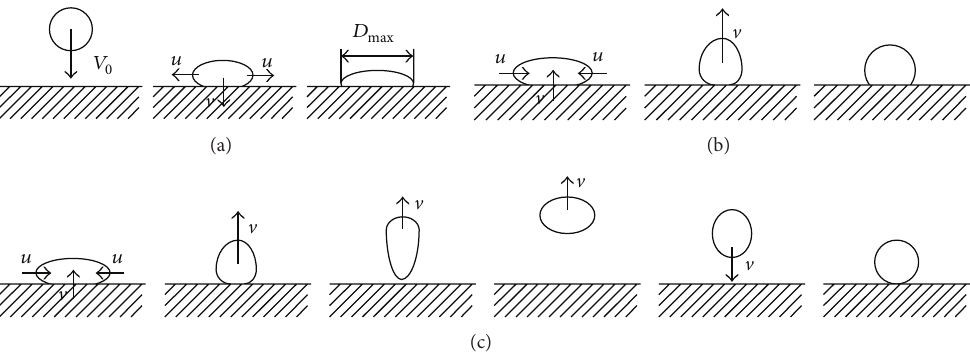
Figure 8: The sketch map of dynamic behaviors of droplet impacting on different solid